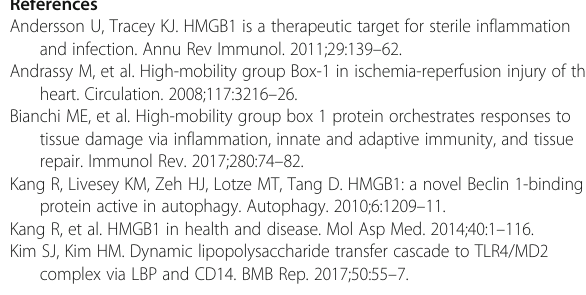
Figure S2. SPR analyses of GST-A-box binding to TLR4/MD-2, TLR4. Figure S3. SPR analyses of GST-B-box binding to TLR4/MD-2, TLR4. Figure S4. SPR analyses of GST-A-box and A-box binding to TLR4/MD-2, TLR4. Figure S5. Ternary complex formation among TLR4, A-box and HMGB1. (DOCX 241